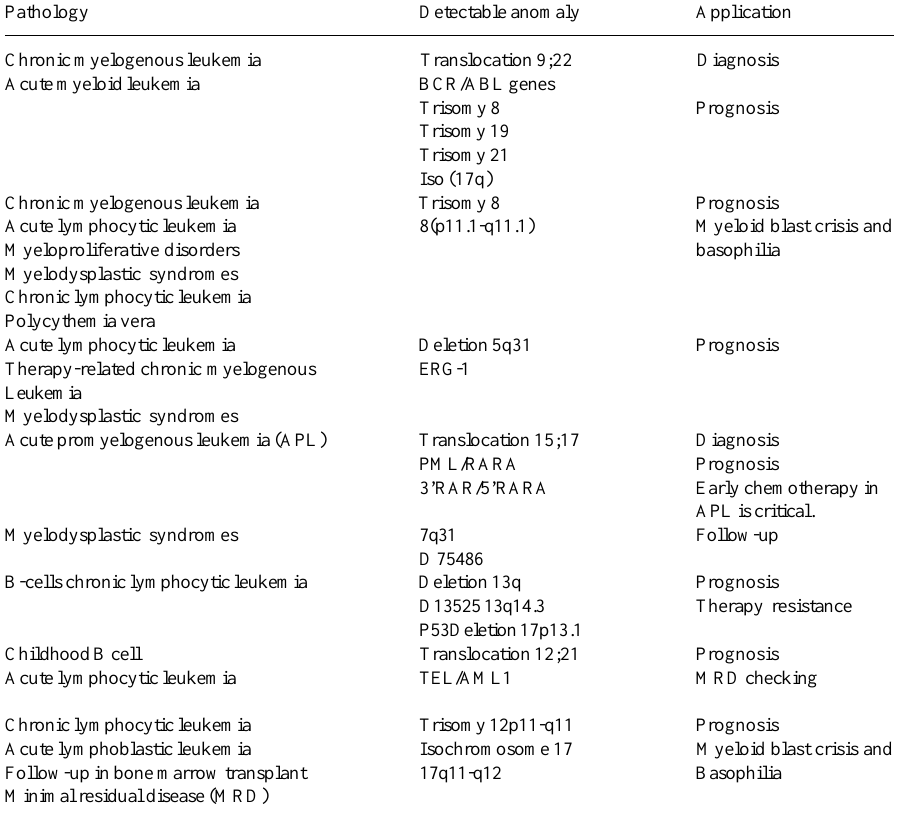
Table I - Hematological